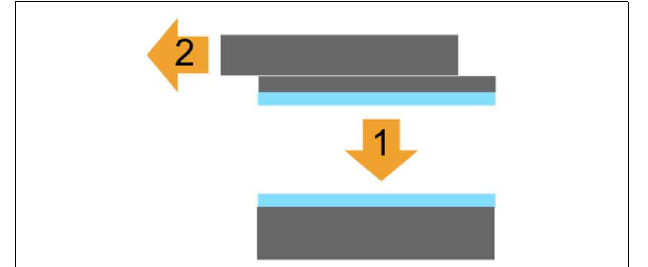
FIGURE 5 | How a silicon-on-insulator (SOI) wafer is made. Each wafer is made from two silicon wafers. The wafers are oxidized, bonded, and one is cut and polished to a thin layer.